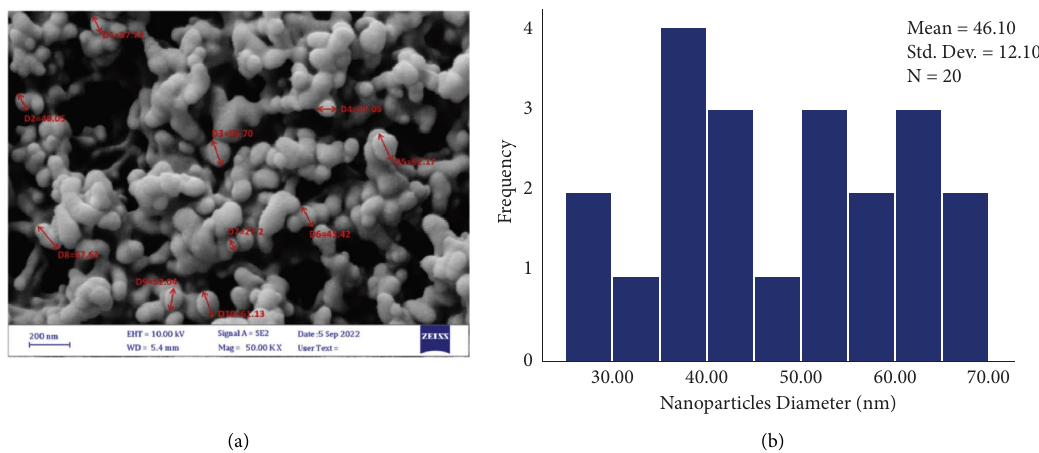
Figure 10: Size estimation of the nanoparticles using the FeSEM images and ImageJ software on the coated SSW. (a) Nanoparticles measurement. (b) Size distribution histogram of the nanoparticles.